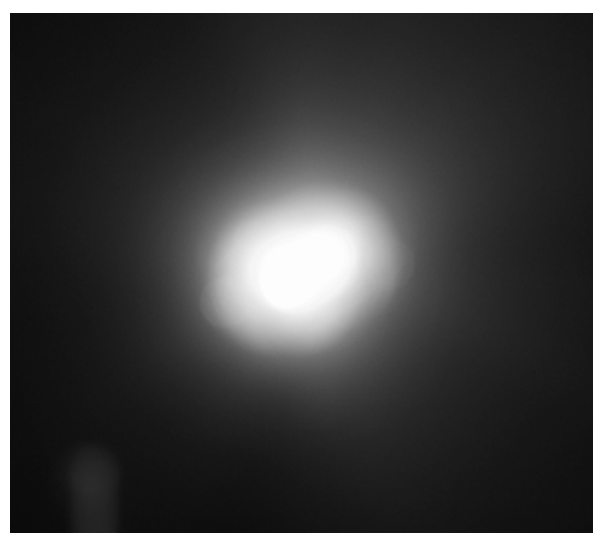
Figure 6. Image of a light source in foggy conditions